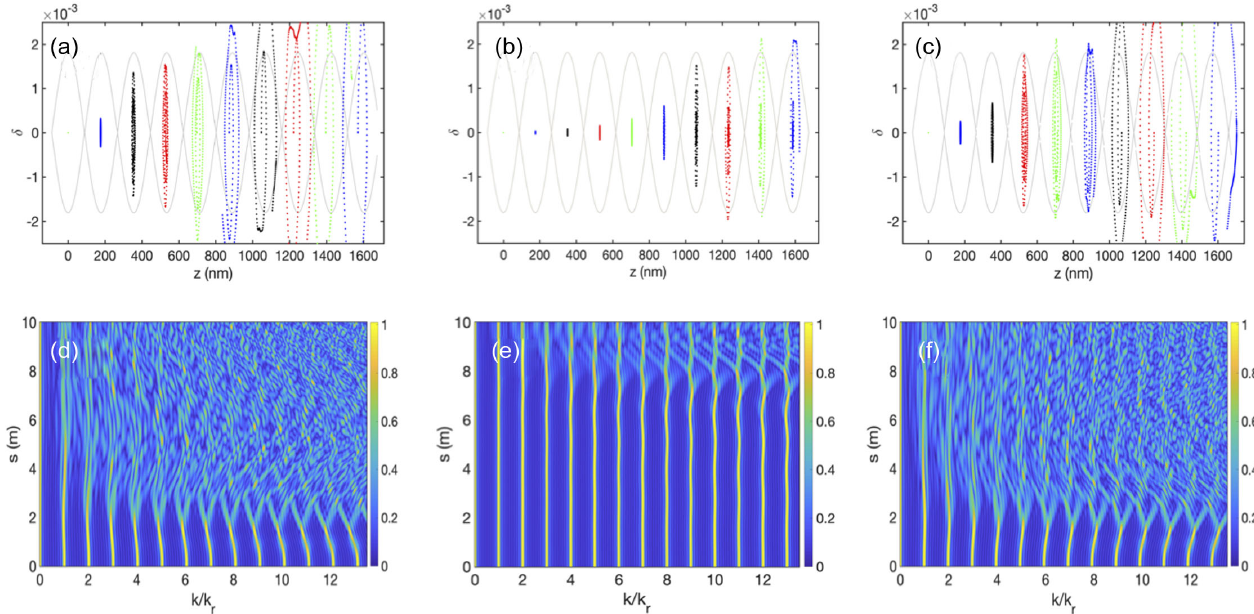
visualization.FIG. 12. (a,b,c) Macroparticle phase space evolution for individual microbunches at s ¼ 10 m with different bunch spacings; (d,e,f) Evolution of the bunching spectrum along the undulator as a function of the normalized wavenumber. The microbunch spacing for the left column assumes Δ L ¼ 0 . 99 λ r , the central column Δ L ¼ λ r , and the right column Δ L ¼ 1 . 01 λ r . For the three cases, the bunch spacing is uniform for all microbunches. See the context for more discussions.